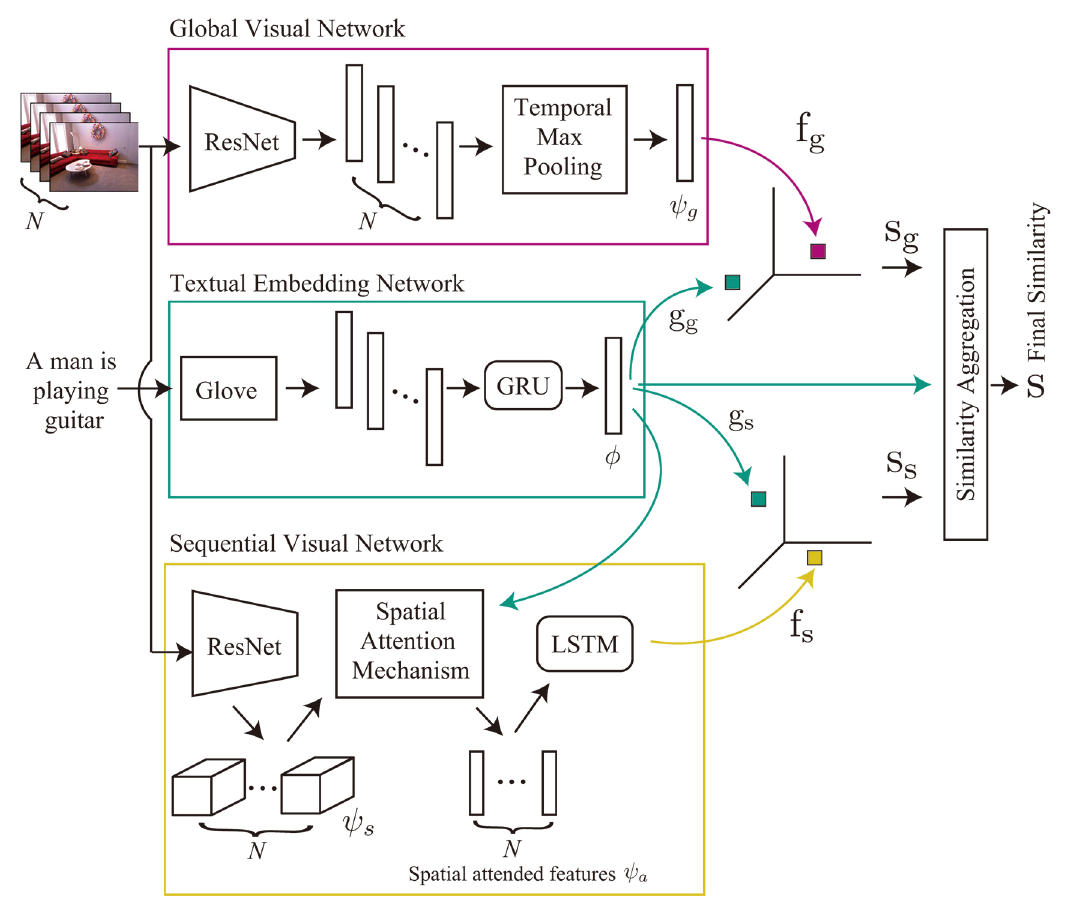
Figure 1. Overview of the proposed framework. f g , f s , g g , and g s are embedding